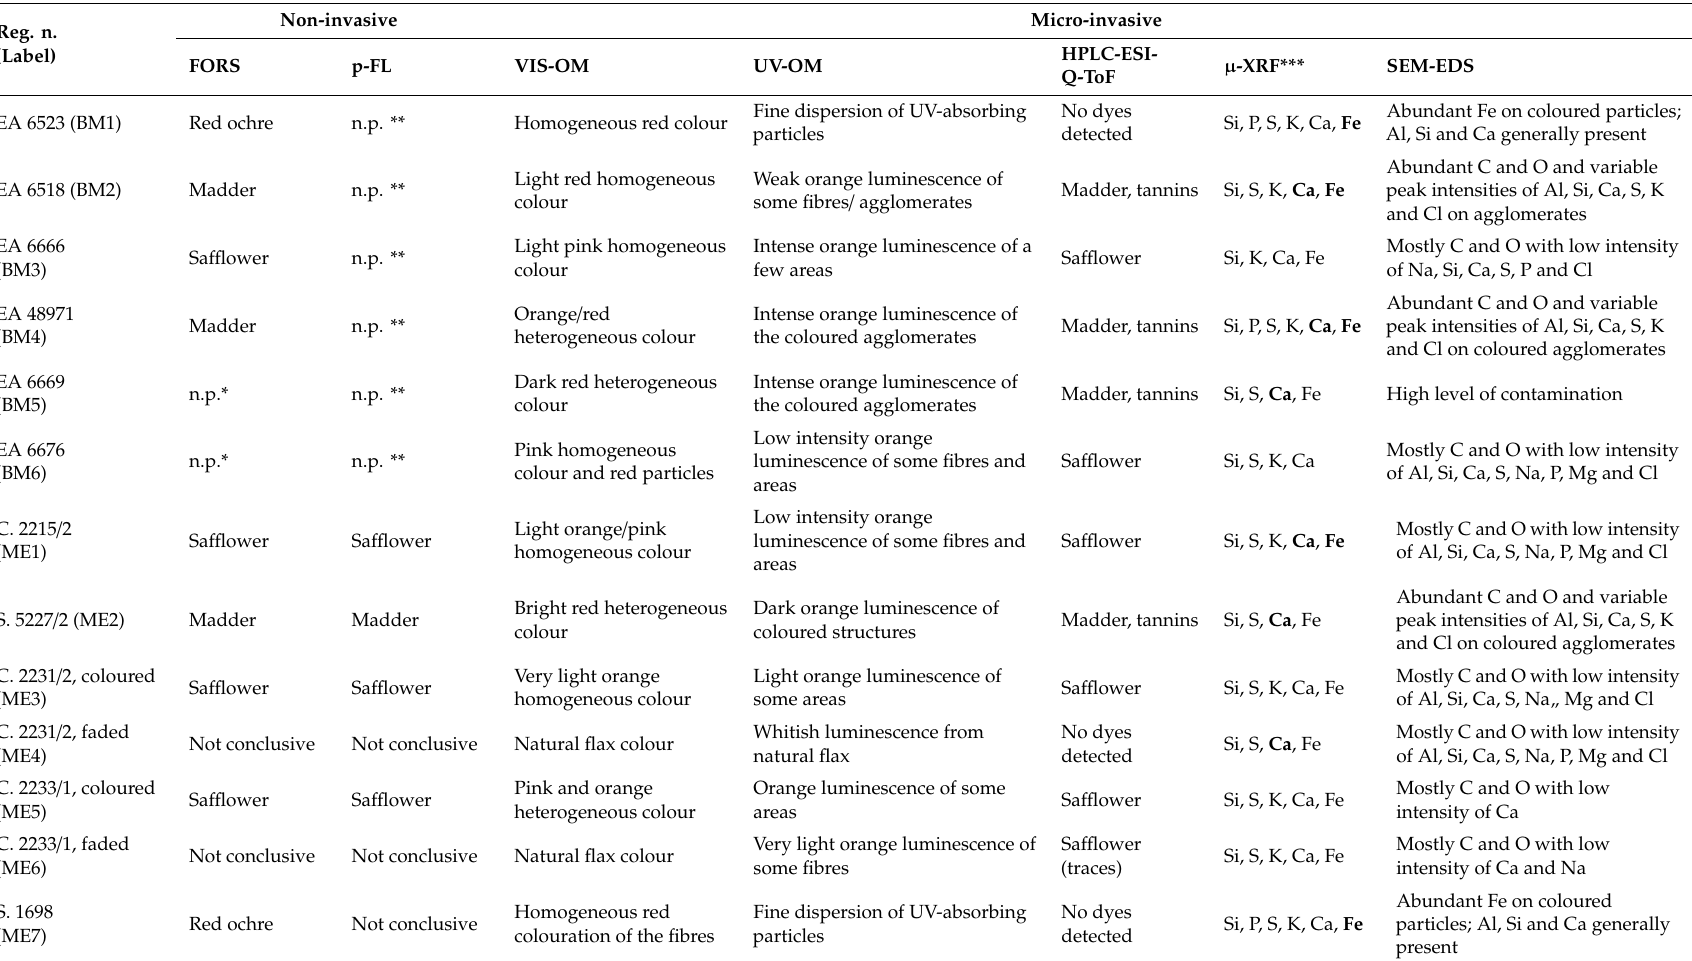
Table 2. Summary of the results obtained in this study